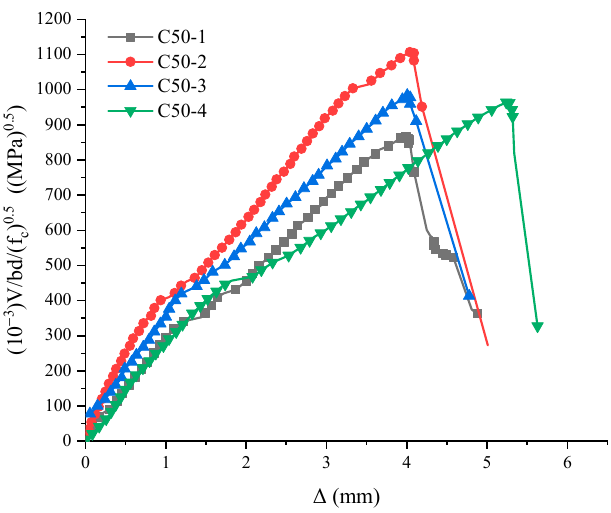
Figure 10. Effect of PFR on load–deflection response for C50 concrete. The load–deflection curves of C40 grade concrete beam with different shear span ra- tios λ are shown in Figure 11. It can be seen that with the increase in shear span ratio, the ultimate load capacity of the beam and its corresponding deflection, the stiffness drops rapidly. Among the samples, B40-5 ( λ = 1) shows diagonal compression failure, and the ultimate load capacity mainly depends on the compressive strength of concrete. B40-6 ( λ = 3) shows diagonal tension failure, and the ultimate load capacity depends on the tensile strength of concrete. Figure 12 shows the load–deflection curves of C40 grade concrete beams at stirrup ratios of 0% (B40-4), 0.22% (B40-7) and 0.33% (B40-8). It is evident that as the shear reinforcement ratio increases, the ultimate shear capacity, the corresponding de- flection and the stiffness of the beam all increase.